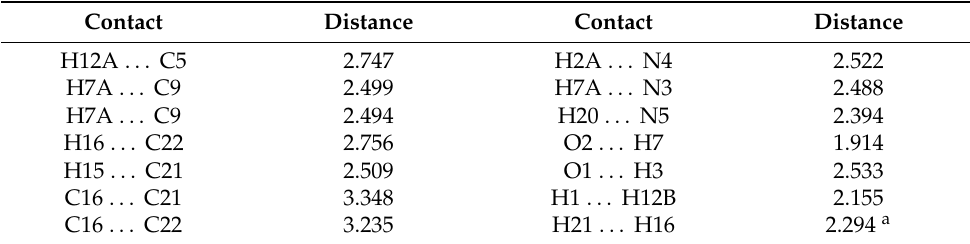
Figure 5. The d norm maps for the important interactions in 4 . A: O…H, B: N…H; C: H…C; D: H…H, and E: C…C contacts. Table 4. Intermolecular interactions in 4 .